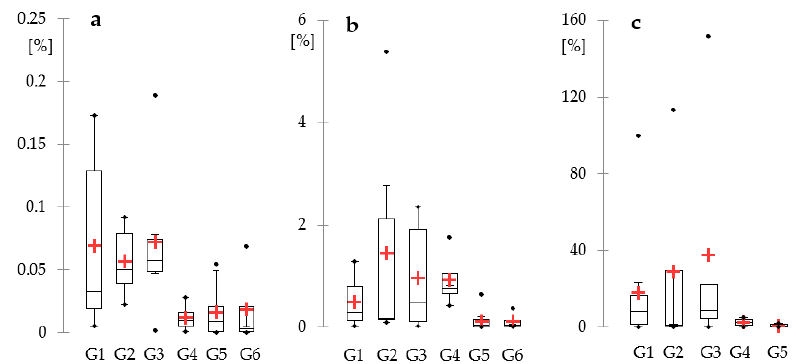
Figure 9. The effectiveness of carbon transfer (%) between the phytoplankton (primary production) and zooplankton (secondary production) in epilimnion ( a ), metalimnion ( b ), and hypolimnion ( c ) in lakes with different oxygen conditions. Note: the differences in scales between the y-axes in the figures.